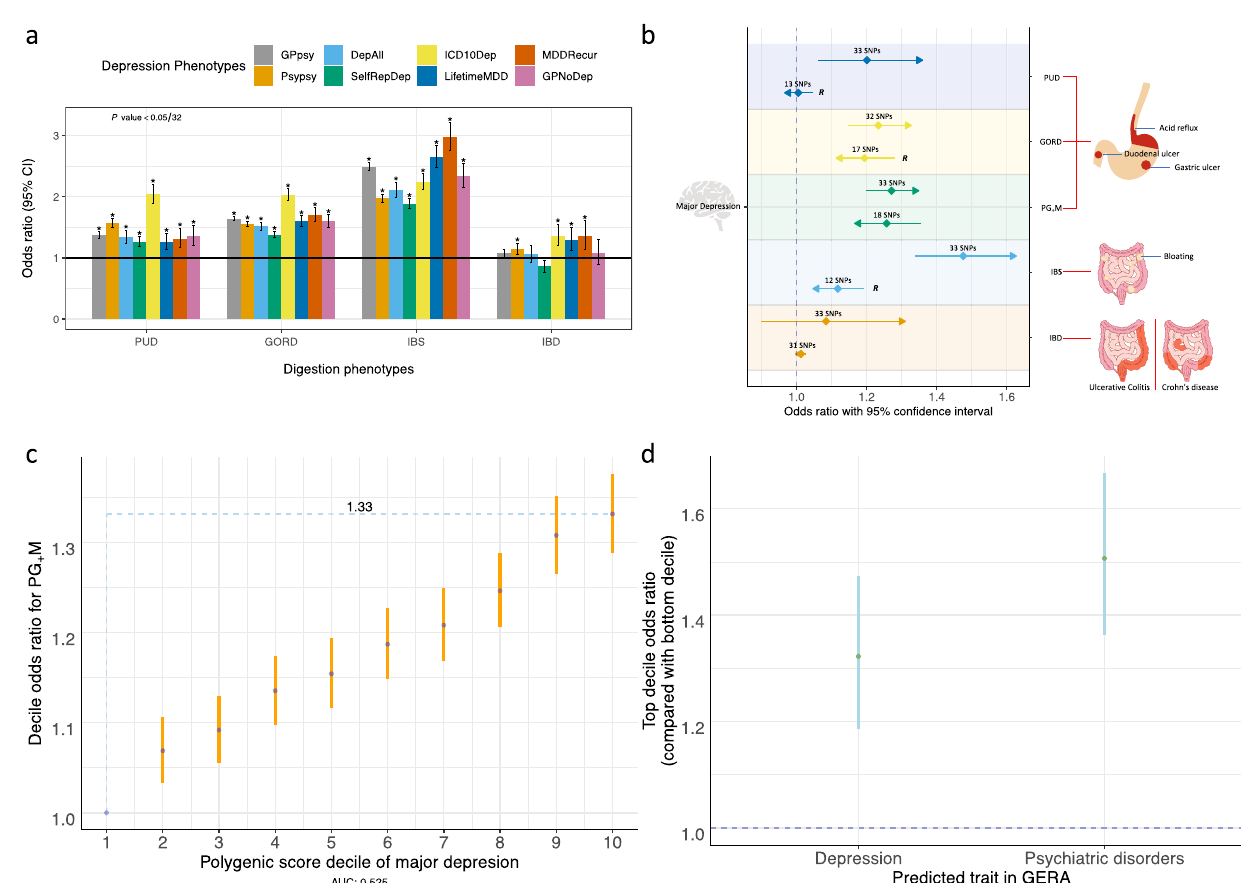
Fig. 6 Comorbidity, Mendelian randomisation and polygenic risk score analyses with depression. a Comorbidity relationship between eight depression phenotypes 68 and each of the PUD, GORD, IBS, and IBD. Odds ratio and 95% CI were calculated based on the 2 by 2 contingency table for number of cases and controls of each of the 32 digestion-depression phenotype pairs (Supplementary Tables 19 and 20). The de fi nitions of the eight depression phenotypes are in the Methods section. “ * ” represents the P value for each digestion and depression pair that remain signi fi cant after Bonferroni correction ( P < 0.05/ 32). b Mendelian randomization (MR) results between major depression (MD) and fi ve digestion phenotypes. The left y axis is for MD while the right y axis is for the fi ve digestion phenotypes. The arrow for each horizontal line represents the direction from exposure trait to outcome trait relative to the y -axis labels. OR and 95% CI are represented as diamond and horizontal lines taking values from x axis. Each digestive phenotype corresponds to two horizontal lines. “ R ” on the right side of the horizontal line represents relaxation of signi fi cance threshold of SNP associations to obtain more SNP genetic instruments (Supplementary Table 21). The number of the SNP instruments used in analyses are shown above the diamond. The common pathological characteristics or symptoms for these phenotype-related diseases are shown on the right side (noting that pathological characteristics or symptoms are not limited to these locations). c Decile of major depression polygenic score predicts PG + M. Odds ratio (OR) and 95% con fi dence intervals (CI, blue dots and orange bars) relative to decile 1 were estimated using logistic regression. The blue dashed lines shows the OR for the highest decile, OR of 1.33 for PG + M related disorders. d OR and 95% CIs (green dots and blue bars) for top decile of PG + M polygenic score predicting depression and psychiatric disorders in the independent GERA cohort 36